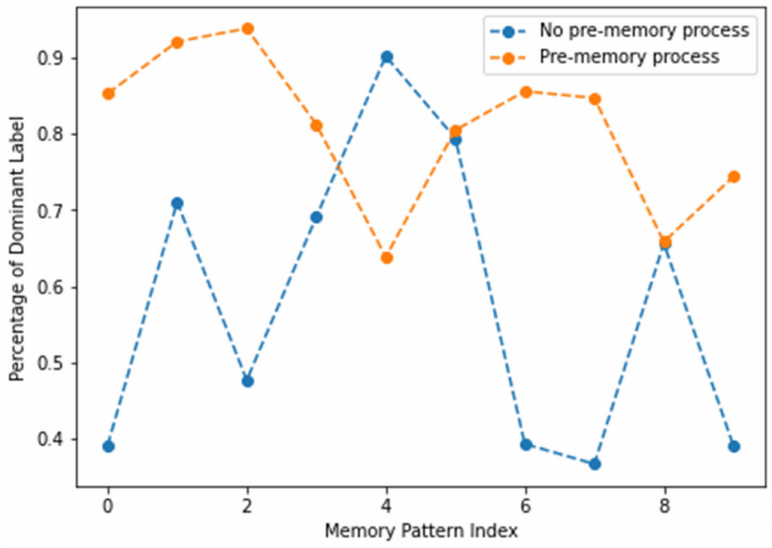
Figure 25. Comparison of the proportion of dominant labels with and without the pre-memory process. The similarity criterion is 20% SDR